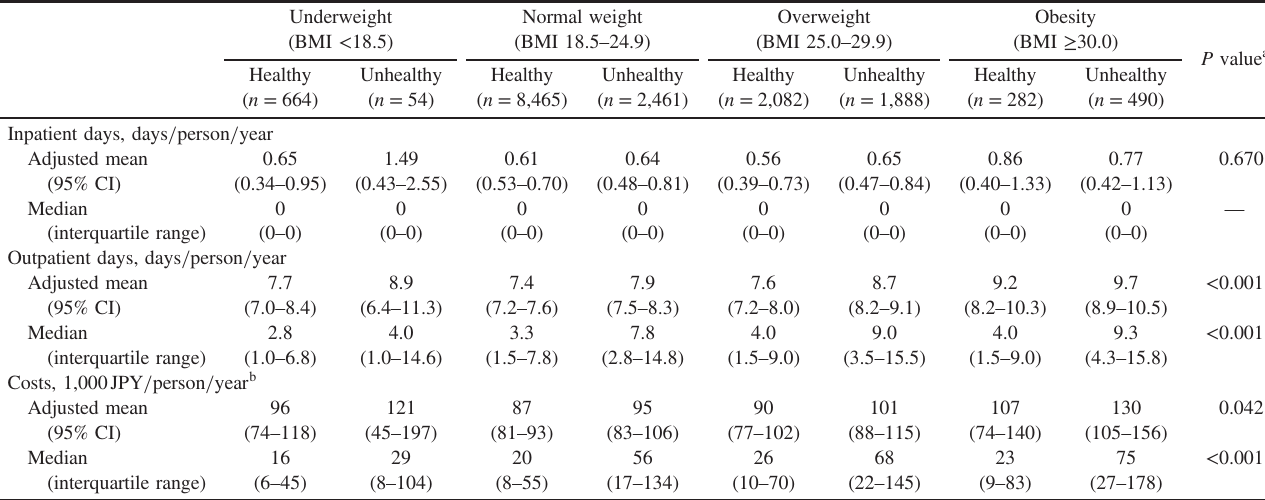
Table 2. 4-year cumulative medical care days and costs according to BMI levels and metabolic health status